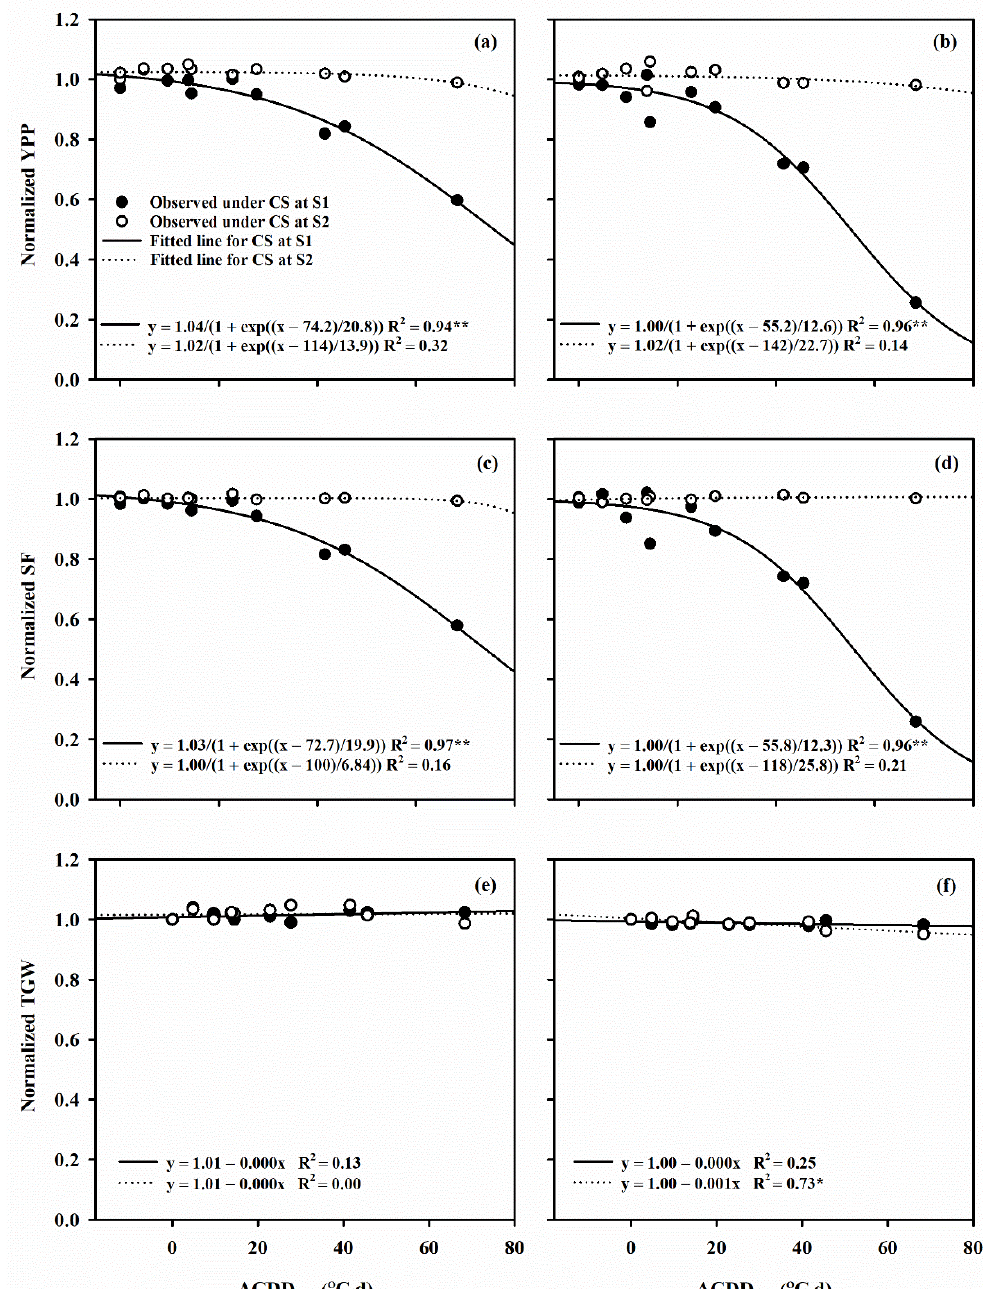
Figure 4. The relationship between the change in canopy temperature based accumulated cold degree days (ACDD CT ) and the relative change in ( a , b ) yield per plant (YPP), ( c , d ) spikelet fertility (SF), ( e , f ) thousand grain weight (TGW) in Huaidao 5 and Nanjing 46, respectively. (S1) flowering stage; (S2) grain filling stage. Capital letters represent Huaidao 5 whereas the small letters represent Nanjing 46. ** represents p < 0.01; * represents p < 0.05).